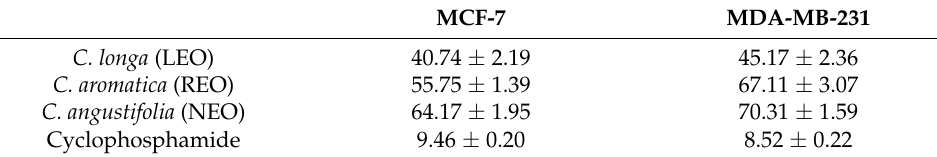
Table 4. Cytotoxic activity of the Curcuma spp. leaf essential oils expressed as IC 50 ( µ g/mL).